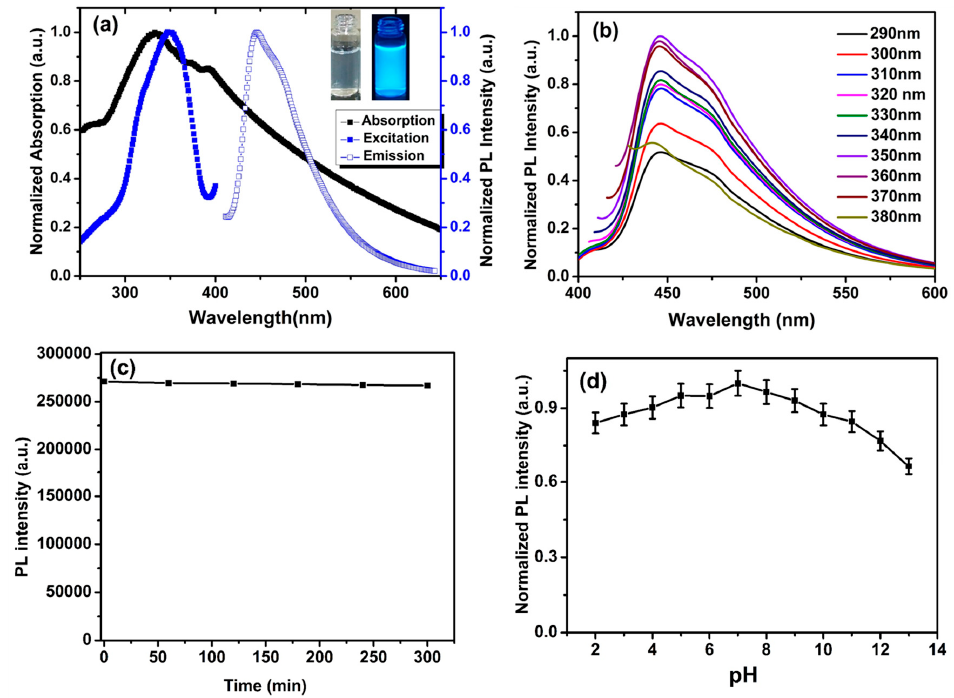
Figure 4. ( a ) UV–vis absorption, photoluminescence excitation, and emission spectra of the aqueous SCNPNS: λ ex = 350 nm, λ em = 445 nm. The inset shows the photographs of the aqueous SCNPNS under visible light irradiation (left) and UV light (365 nm, right). ( b ) Normalized fluorescence spectra of the aqueous SCNPNS at different excitation wavelength. ( c ) Photobleaching stability under 365 nm UV light for 300 min, and ( d ) pH effect on the fluorescence intensity of aqueous SCNPNS. Note: the SCNPNS in the aqueous solution is abbreviated as aqueous